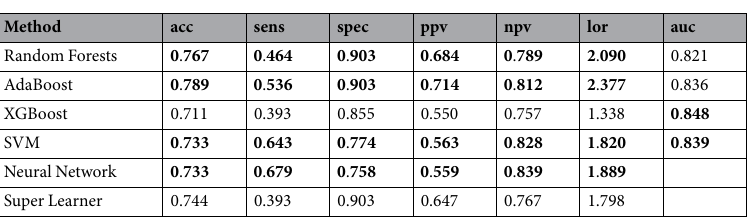
Table 18. Performance of model-based and model-free methods (using all features) for Tel-Aviv dataset to predict no fall or at least two falls, contrast to results in Table 10 (fall/no-fall), using the same features.